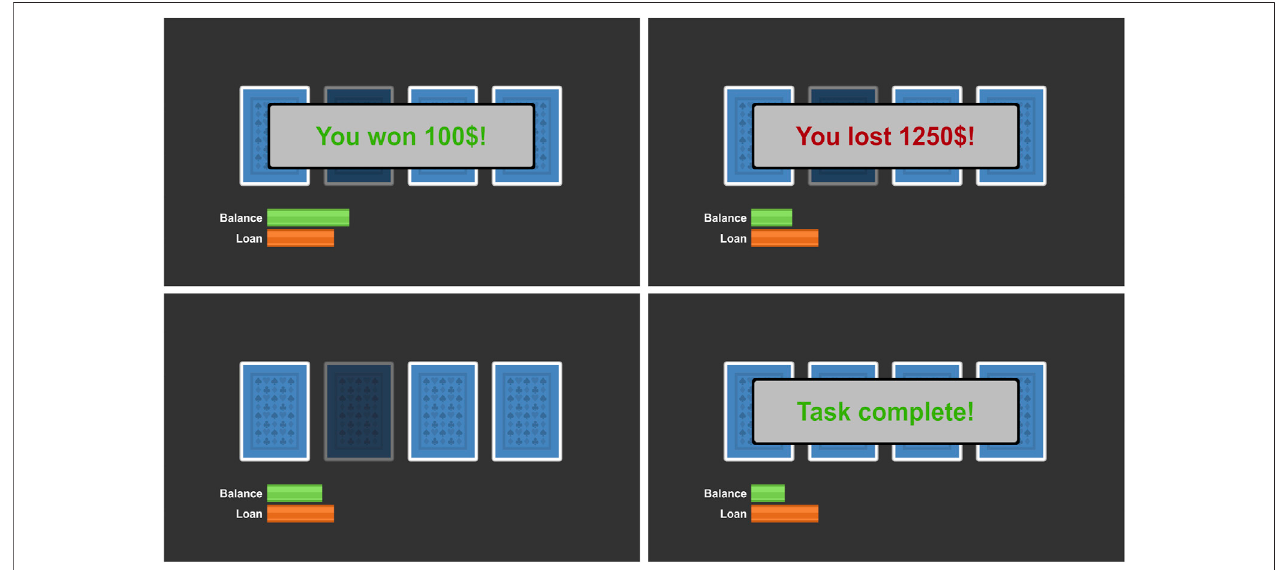
FIGURE 2 | Decks are displayed lying face down. The orange bar indicates a player ’ s loan and the green bar represents the current balance. Top left: The player ’ s win is displayed for 2 s. Top right: The loss is shown for 2 s. Bottom left: A player drew all cards from a deck. Bottom right: The player drew 100 cards and fi nished the